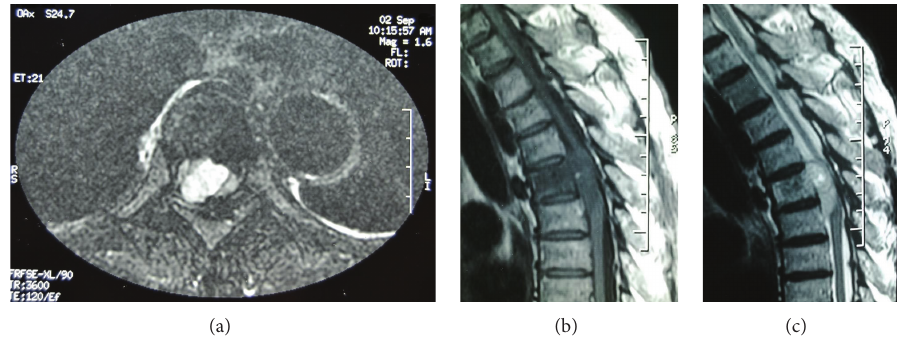
Figure 1: Preoperative axial (a) and sagittal (b) T1-weighted and sagittal (c) T2-weighted MR images through the thoracic spine showing a T1 hypointense, T2 hyperintense, extradural process at T5 level with important spinal cord compression. Note the T5 vertebral body signal changes.